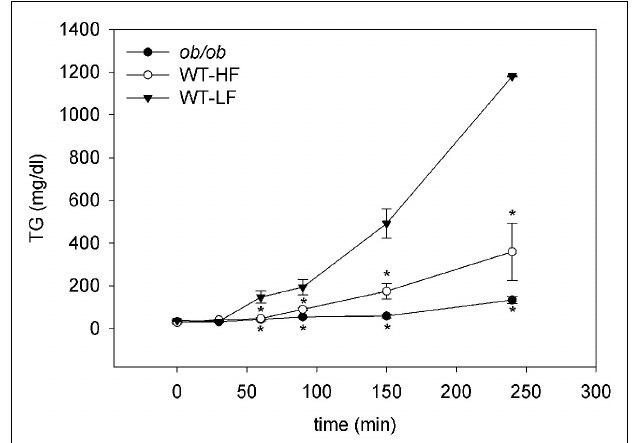
FIGURE 5 | Oral fat tolerance tests. Fasted mice given the LPL-inhibitor Tyloxapol were gavaged with an olive oil bolus as described in Section “Materials and Methods.” Average ± SEM, n = 4 per group, * p < 0.05 or lower